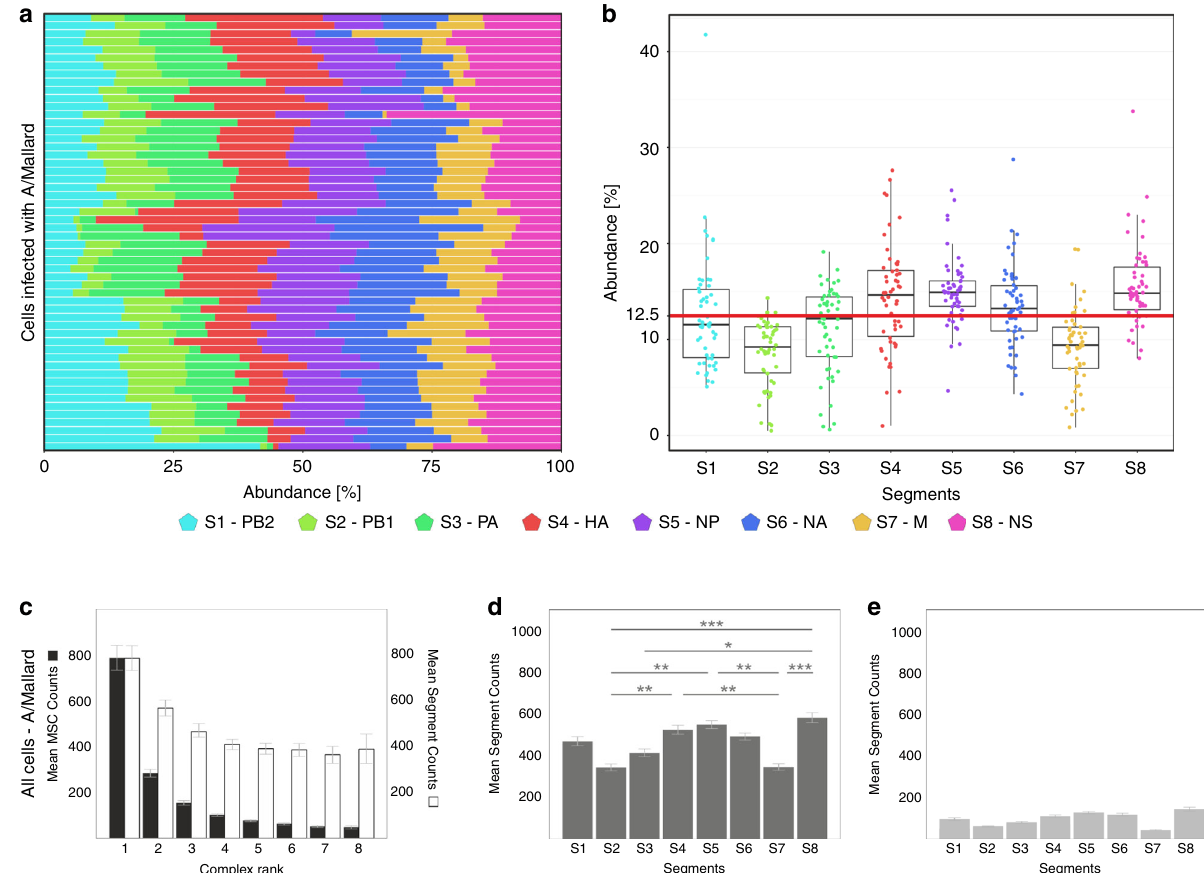
Fig. 6 Viral RNA (vRNA) and MSC rank abundances in A/Mallard-infected A549 cells 10 h.p.i. a Relative abundances of all vRNA segments per cell as measured by fl uorescence in situ hybridisation (FISH). For each of the measured cells ( n = 54 from three independent experiments), the number of spots that were detected was counted and normalised to the total number of spots per cell. The colouring scheme is the same as in Fig. 1. b Data shown in a in a Tukey boxplot representation. Upper bound of box, centre and lower bound of box represent the 75th percentile, the 50th percentile (median) and the 25th percentile, respectively. Upper and lower whiskers represent the maxima and minima of the boxplots showing the respective largest or smallest value within 1.5× interquartile range above the 75th or below the 25th percentile (bounds of box). In all, 12.5% (red line) corresponds to the expected fraction for each vRNA in a uniform distribution. For the segments, no signi fi cant difference (ANOVA, F test, one-sided, α = 0.05) between the cells was found ( P > 0.999). The Bartlett test (one-sided, α = 0.05) shows that the variability of the individual segments is signi fi cantly different ( P > 0.0001) (see also legend to Fig. 3). The Kruskal – Wallis test does not presuppose homogeneity of variability, but agrees with the F test in the result, i.e., no signi fi cant